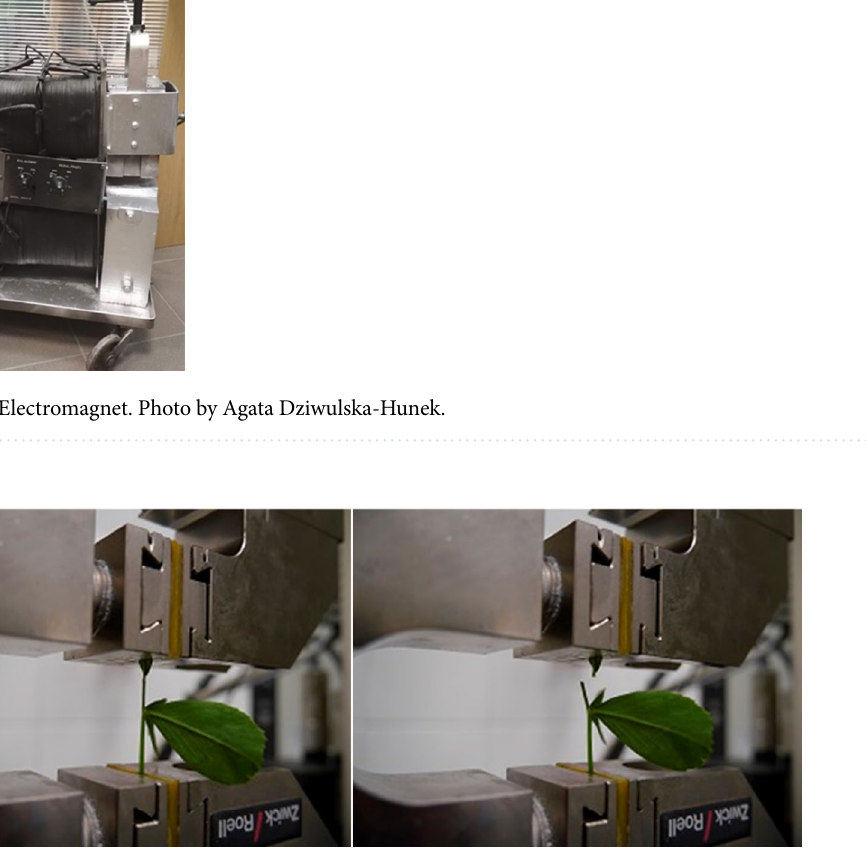
Figure 3. Before and after tensioning with the Zwick/Roell Z005 instrument. Photo by Agata Dziwulska- Hunek.